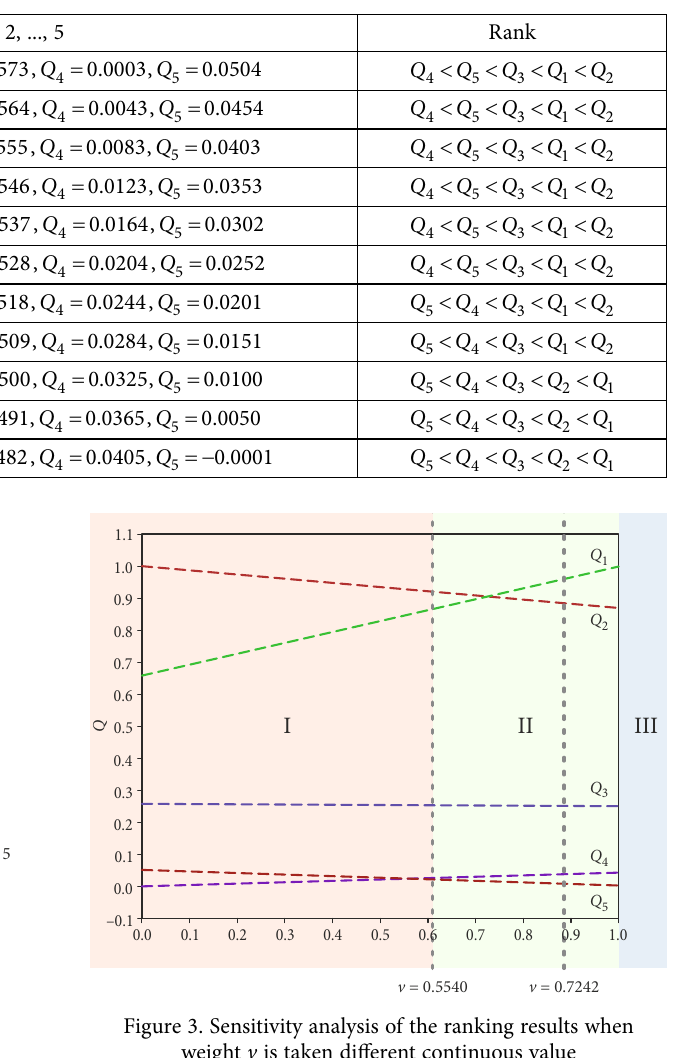
Table 2. Values of Q i and bidders’ ranks